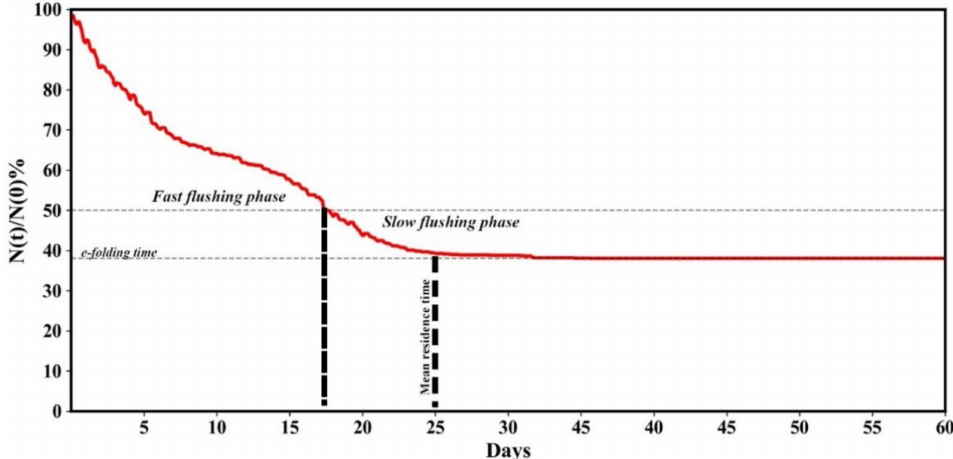
Figure 11. The residence time of CE during the monsoon season was calculated with a resolution of 300 m. A total of 2584 particles were realised over the model domain. N (0) is the initial number of particles in the domain and N (t) is the number of particles at time t. The percentage of particles initially reduced from 100% to 50% in the model domain is considered as the fast flushing phase, followed by a slow flushing